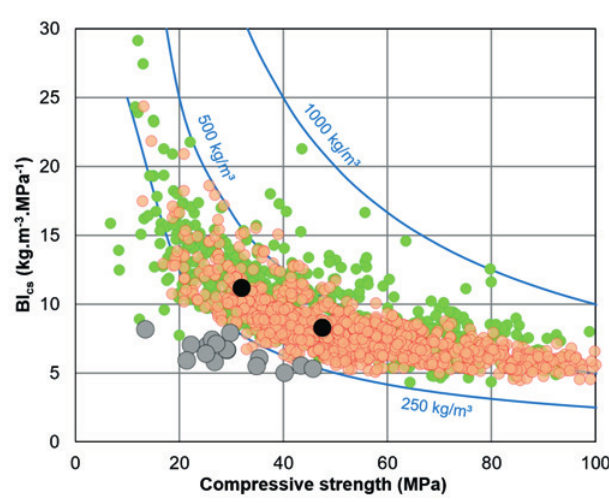
Correlation between paste porosity and BI of studied concretes. Red dots are low-packing concretes made from pure cement (paste); blue dots are high-packing concretes made from limestone-cement (paste)